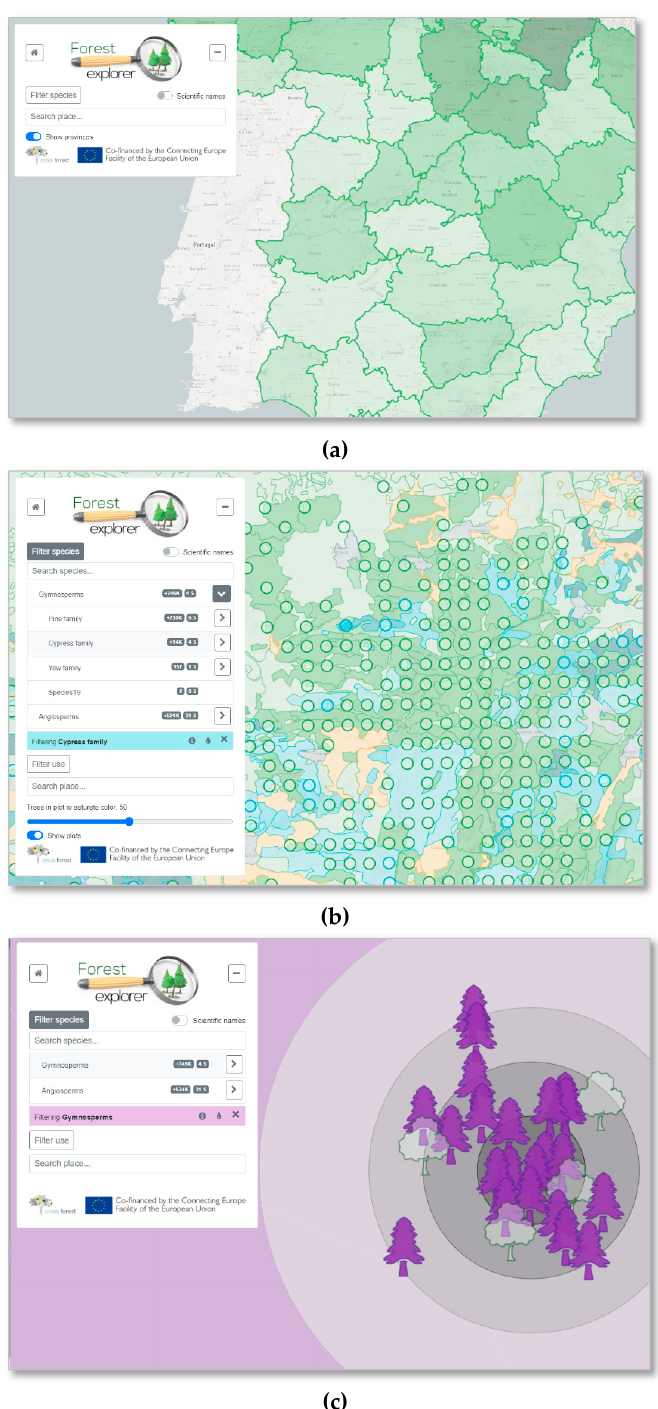
Figure 2. Screenshots of Forest Explorer User Interface: ( a ) Forest Explorer at minimum zoom level showing Spanish provinces. ( b ) Forest Explorer at medium zoom level showing concentrations of trees within a particular zone. ( c ) Forest Explorer at full zoom level showing all trees contained in the dataset. Retrieved from: https://forestexplorer.gsic.uva.es/.